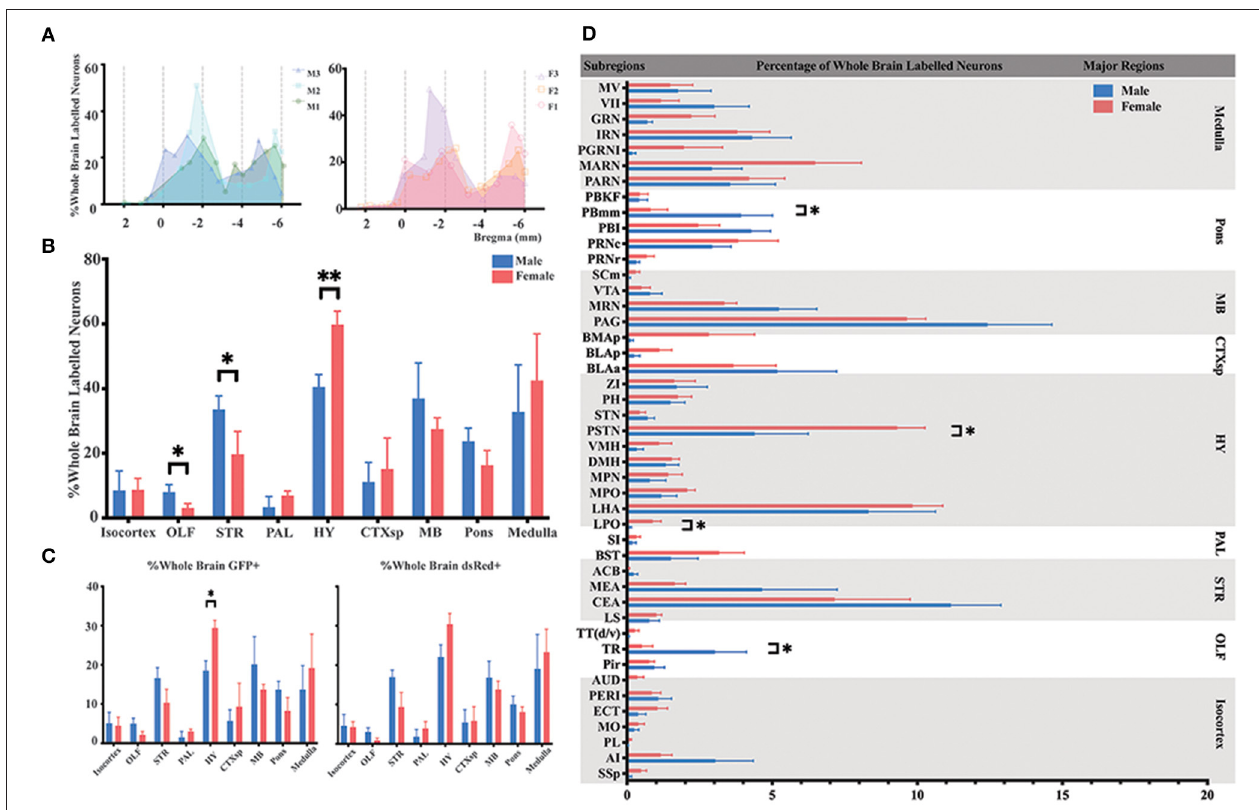
FIGURE 2 | Distribution patterns of whole-brain inputs to the ELGs. (A) Whole-brain distribution of all labeled neurons along the AP axis. Colored lines, input distribution for the individual mouse; colored line with a shaded area under it, average labeled distribution (left, male; right, female). M1–3, male mouse 1–3; F1 – 3, female mouse 1–3. (B) Whole-brain distribution of the labeled neurons within nine major brain regions from bilateral hemispheres, quantified with all slices. (C) The proportion of GFP + and dsRed + in nine major brain regions from bilateral hemispheres, quantified with all slices (left, GFP + ; right, dsRed + ). (D) Whole-brain distribution of all labeled neurons within 45 subregions in bilateral hemispheres (only significant differences have been labeled on the corresponding top of the bars, otherwise n.s.). GFP + , dsRed + , n.s., no significant difference; * p < 0.05 and ** p < 0.01.